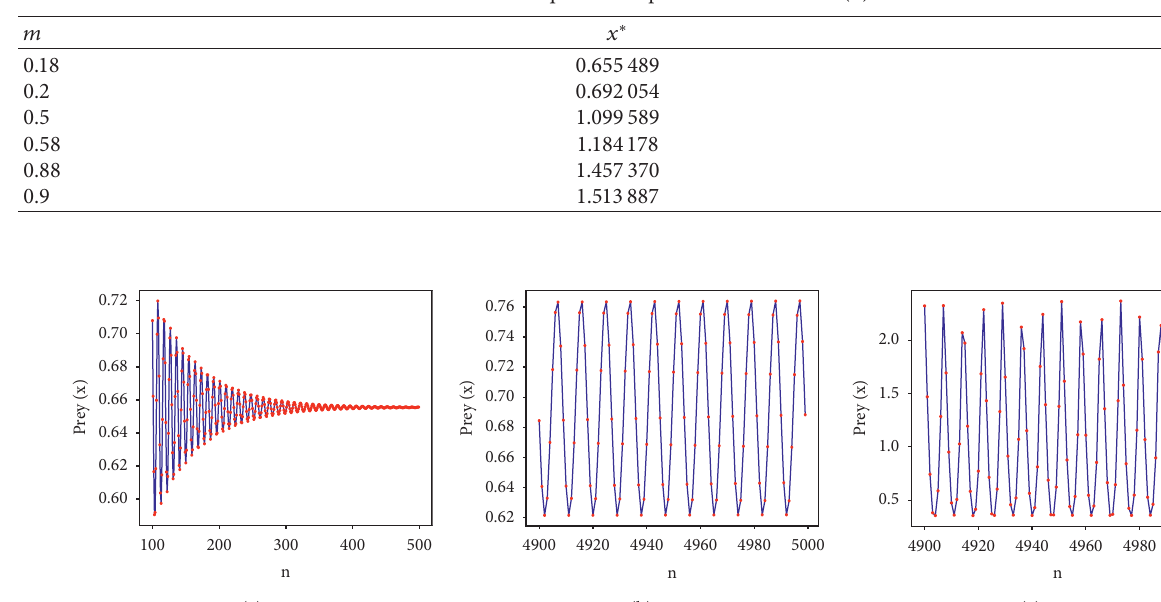
� 4, a � 1 . 15, g � 2 . 7, b � 1 . 2, r � 1, h � 1 . 06, and c � 1 . 9 (a) asymptotically stable for 1 2